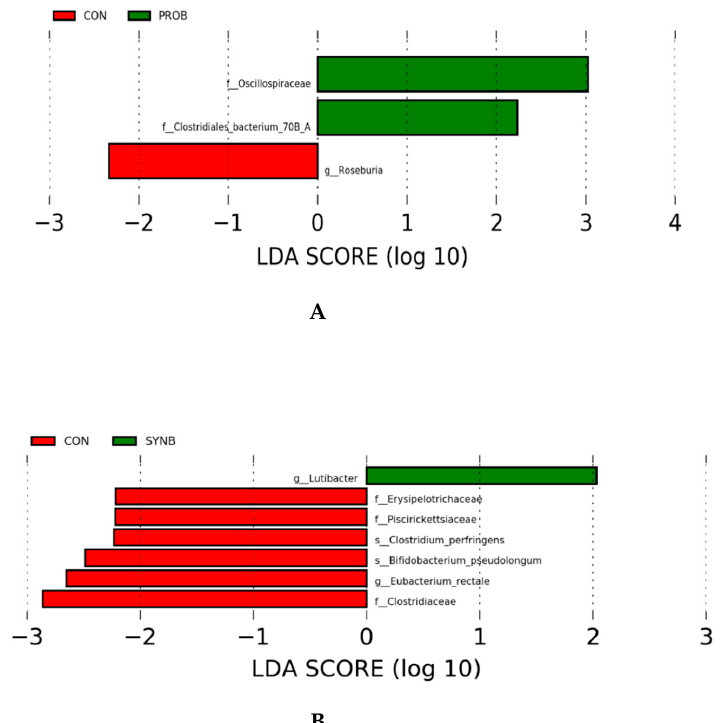
Figure 3. Linear discriminant analysis effect size of the ruminal transcriptionally active microbial community of beef steers fed diet supplemented with direct-fed microbials containing multiple microbial species and their fermentation products. ( A ) CON vs. PROB, ( B ) CON vs. SYNB. CON = control; PROB = a blend of S. cerevisiae , Enterococcus lactis, Bacillus subtilis, Enterococcus faecium, and L. case i, and their fermentation products fed at 19 g/steer/day (PMI, Arden Hills, MN); SYNB = a blend of live S. cerevisiae and the fermentation products of S. cerevisiae, Enterococcus lactis , Bacillus licheniformis , and Bacillus subtilis fed at 28 g/steer/day PMI, Arden Hills, MN).